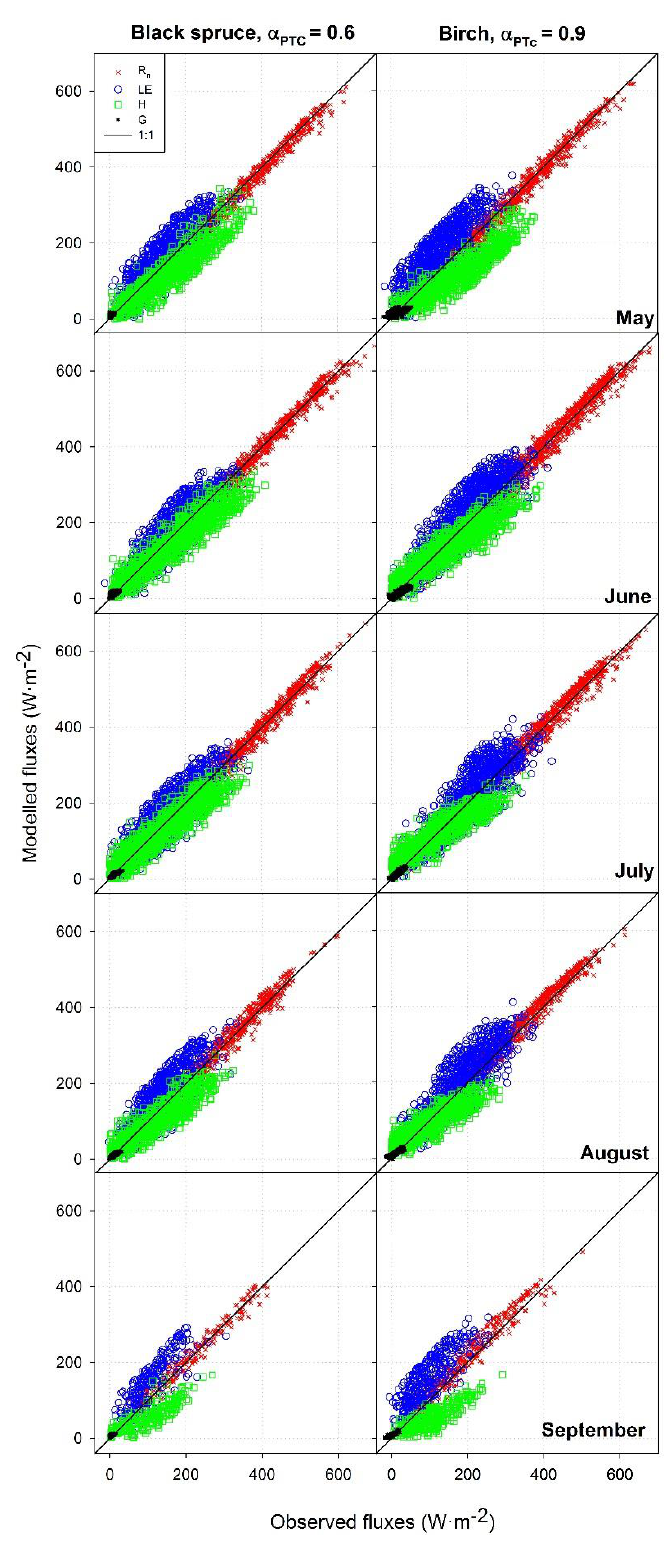
Figure 4. Comparison of modelled vs. observed 30-min fluxes monthly aggregated using an initial TSEB α PTC value 0.6 for black spruce setting and 0.9 for birch setting and G estimated by the G-T RAD relationship. Perfect agreement is represented by the 1:1 line.